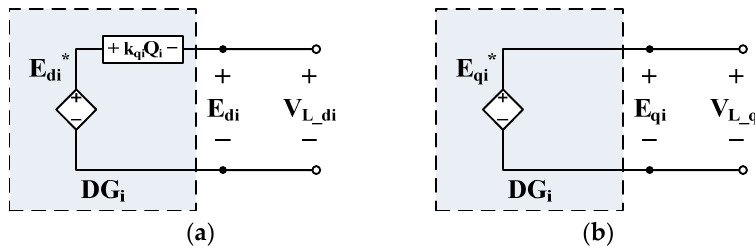
Figure 3. d ‐ q equivalent circuits for DGs connected to load neglecting the line impedance: ( a ) d ‐ axis; ( b ) q ‐ axis.